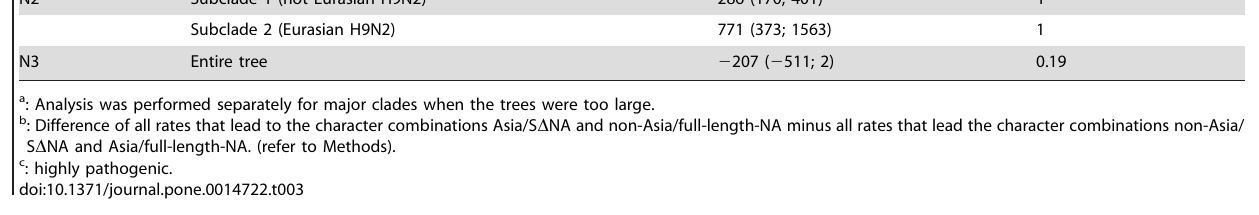
Posterior probability that D Q . 0